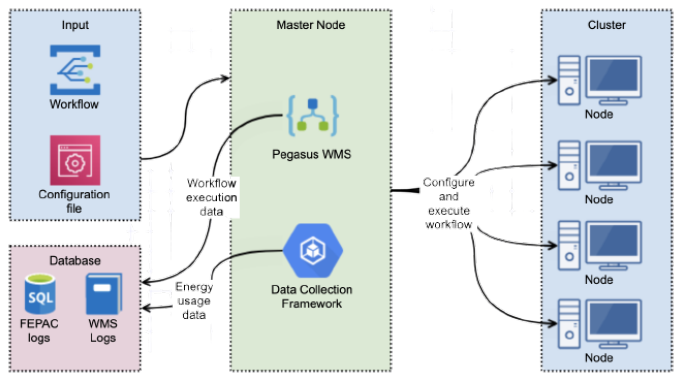
Figure 2. Data Collection Experiment